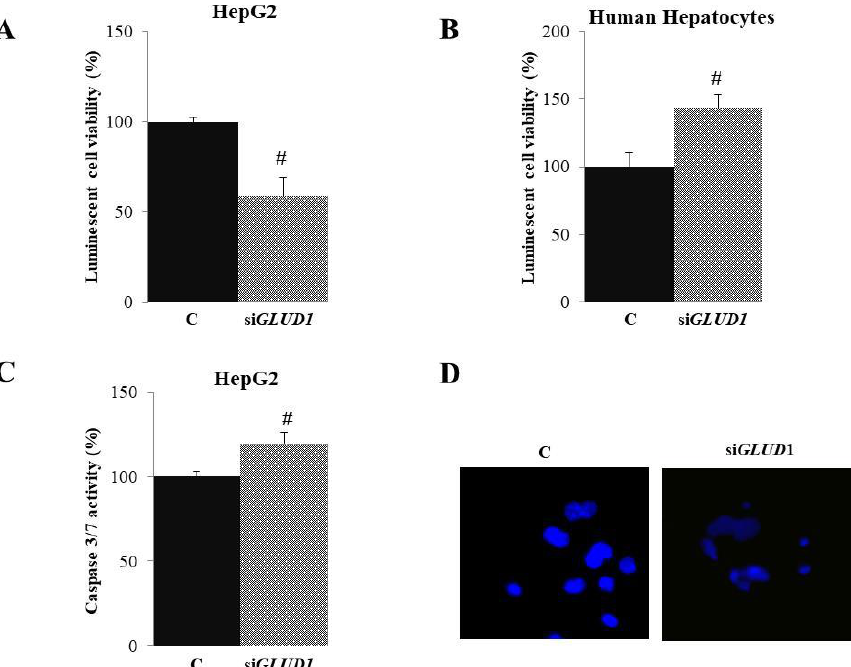
Figure 2. Apoptotic effect of GLUD1 siRNA. HepG2 and Human Hepatocytes were transfected with siRNA targeting human GLUD1 (si GLUD1 ) or control scramble siRNA ( C ). ( A , B ) Seventy-two hours later, cell viability was assessed by using Promega CellTiter-Glo ® 2.0 Assay. ( C ) Twenty-four hours after GLUD1 gene silencing, HepG2 cells were assayed for caspase 3/7 and ( D ) stained with DAPI followed by visualization under fluorescence microscope (magnification 20×). Images in ( D ) are representative of three independent experiments with similar results. In ( A – C ), means ± S.D. of